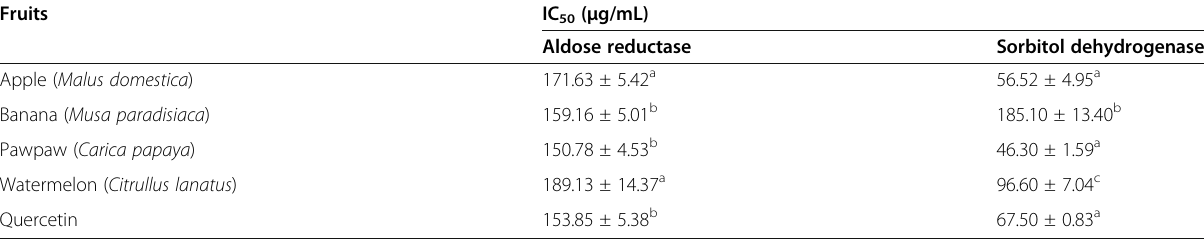
The values are expressed as means ± SEM of triplicate determinations. Means down vertical column not sharing a common letter are significantly different ( p < 0.05) from each